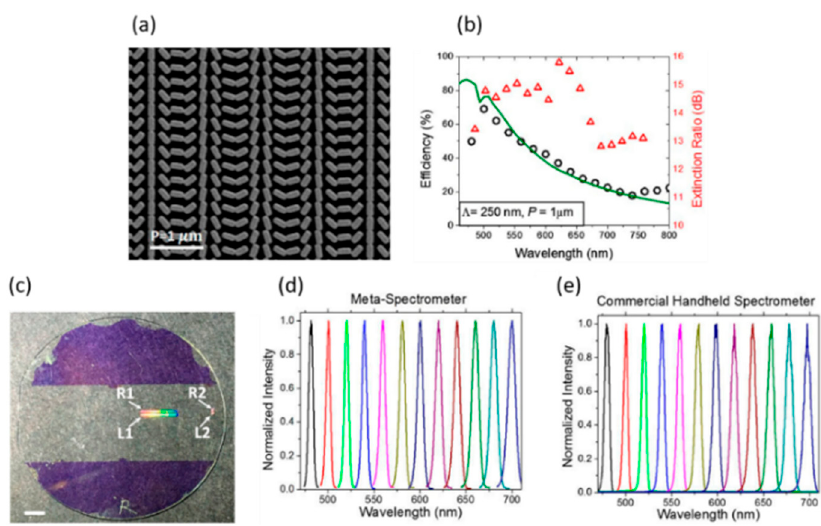
Figure 15. Ultra-compact visible chiral spectrometer with metalens. ( a ) Scanning electron microscope image of a fabricated off-axis metalens. ( b ) Measured ( black circles ) and simulated ( green line ) efficiencies of the +1 order metasurface grating under illumination with right-handed circularly polarized light. Extinction ratio ( red triangles ) of the meta-grating as a function of wavelength. ( c ) Photograph of a fabricated device with four separate metalenses labeled R1, R2, L1, and L2. ( d ) Measured spectra from a supercontinuum laser with 5 nm bandwidth using the metalens spectrometer. ( e ) Measured spectra from a commercial handheld spectrometer, the center wavelength varied from 480 nm to 700 nm. (Reproduced from [101] with permission.)